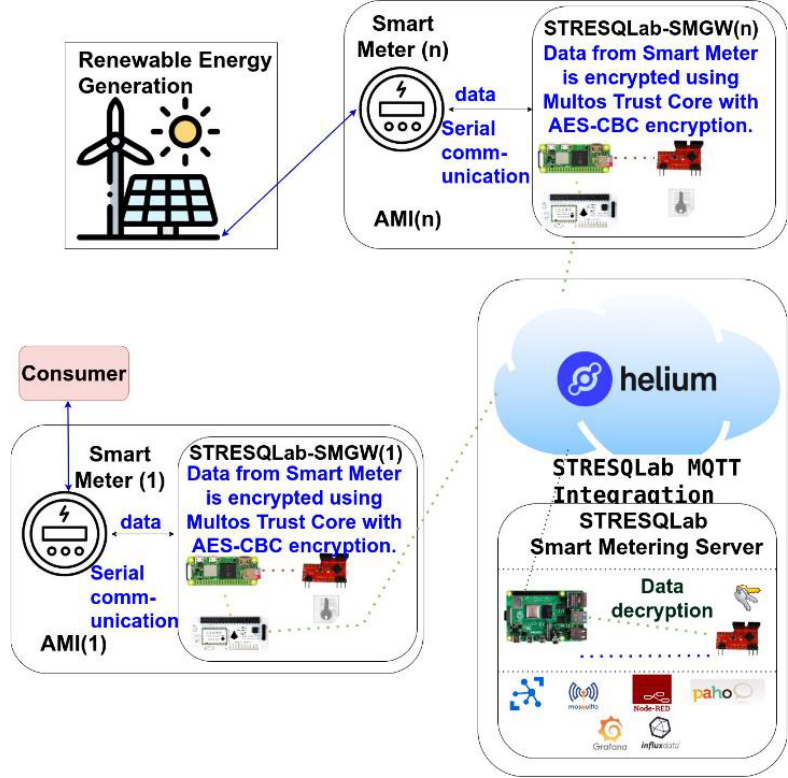
Figure 17. Block diagram of the IoT system.